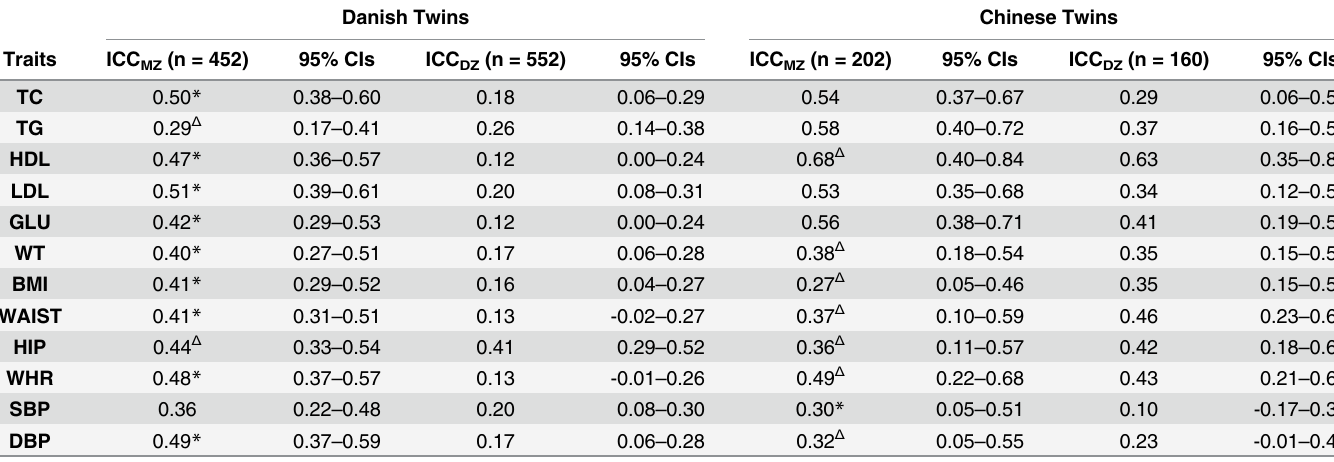
Table 2. ICCs for longitudinal change of each phenotype in Danish and Chinese twins.